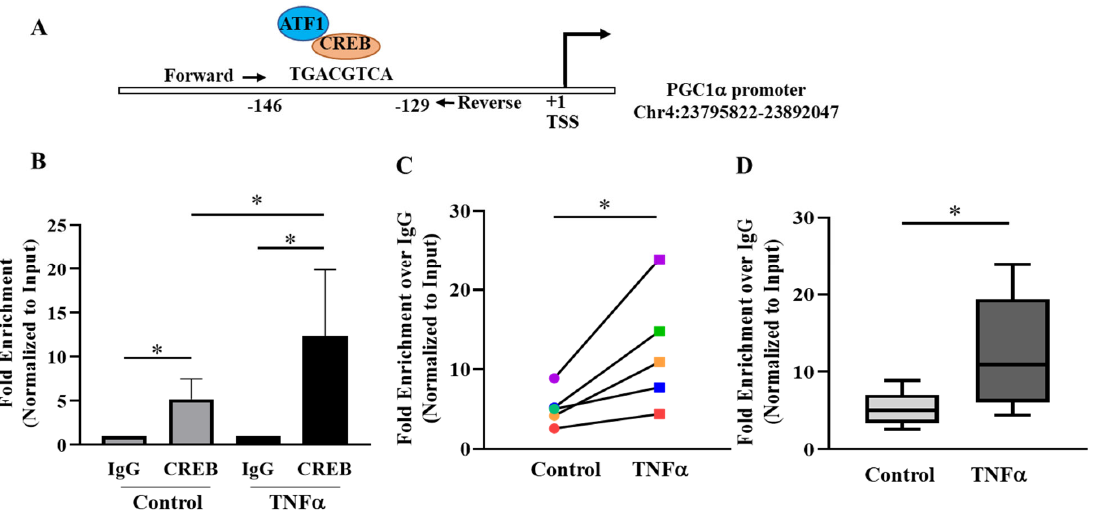
Figure 6. Assessment of PGC1 α promoter occupancy by pCREB S133 in hASM cells. ( A ) Putative bind ‐ ing site for pCREB S133 and pATF1 S63 in the promoter region of PGC1 α was predicted by bioinformat ‐ ics analysis. ( B ) pCREB Ser133 binding to the PGC1 α promoter region was confirmed in hASM cells treated with TNF α (20 ng/mL for 6 h) and untreated hASM cells by chromatin immunoprecipitation assay (ChIP). The data obtained by ChIP ‐ qPCR were represented as the fold enrichment over IgG control and normalized as % of input DNA. ( C ) In each of the five patient hASM samples (repre ‐ sented by different colors), pCREB Ser133 binding to the PGC1 α promoter region was significantly higher in TNF α‐ treated (squares) compared to untreated (circles) control hASM cells (* p < 0.05; n = 5). ( D ) The results of pCREB Ser133 binding to the PGC1 α promoter region across the five patient hASM samples were summarized by a box ‐ whisker plot showing the median and minimum to maximum distribution. Statistical analysis of pCREB Ser133 binding to the PGC1 α promoter region was per ‐ formed on n = 5 hASM samples (patients) using a paired t ‐ test (* p < 0.05).